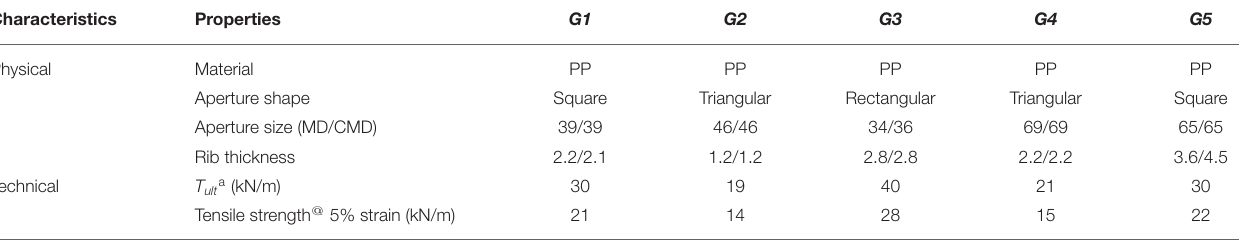
TABLE 2 | Physical characteristics and technical characteristics of geogrid used in the current study.